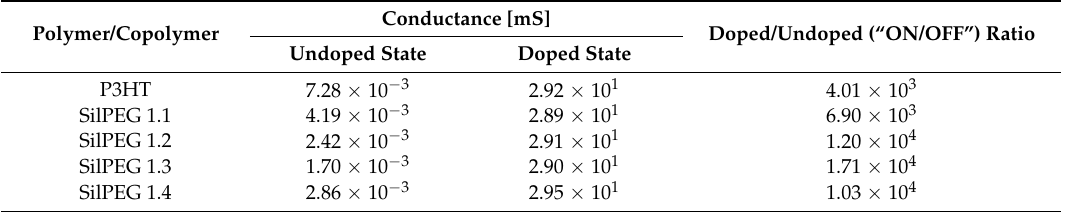
Table 5. “ON/OFF” conductance ratios for the investigated polymer films.